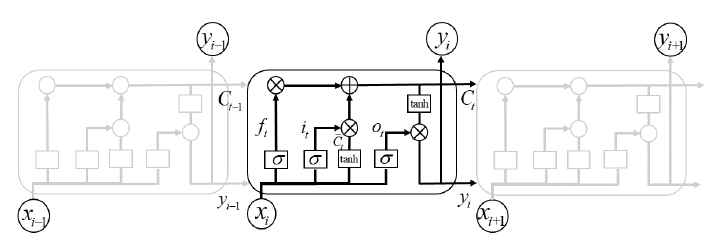
Figure 4. Network structure of